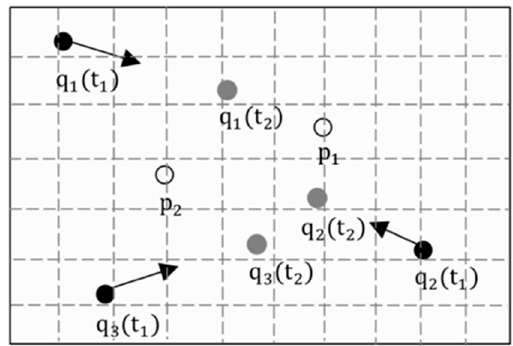
Figure 3. Example of a continuous aggregate nearest neighbor queries (CANNQ).